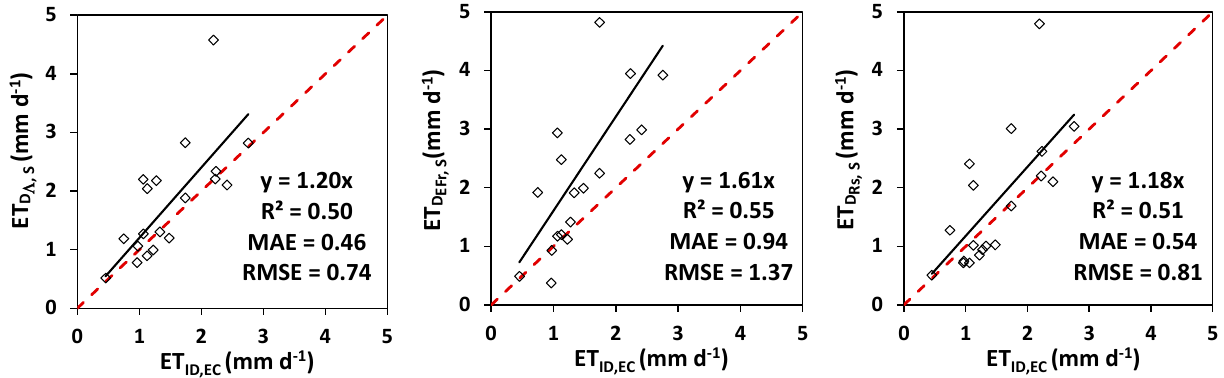
Figure 9. Eddy covariance measured evapotranspiration (ET ID, EC ) and SEBAL estimated evapotranspiration based on Λ scaling factor (ET D Λ , S ), EF r scaling factor (ET DEFr, S ) and Rs 24 /Rs i scaling factor (ET DRs, S ) during the images acquisition days. The red dashed line represents the 1:1 line.